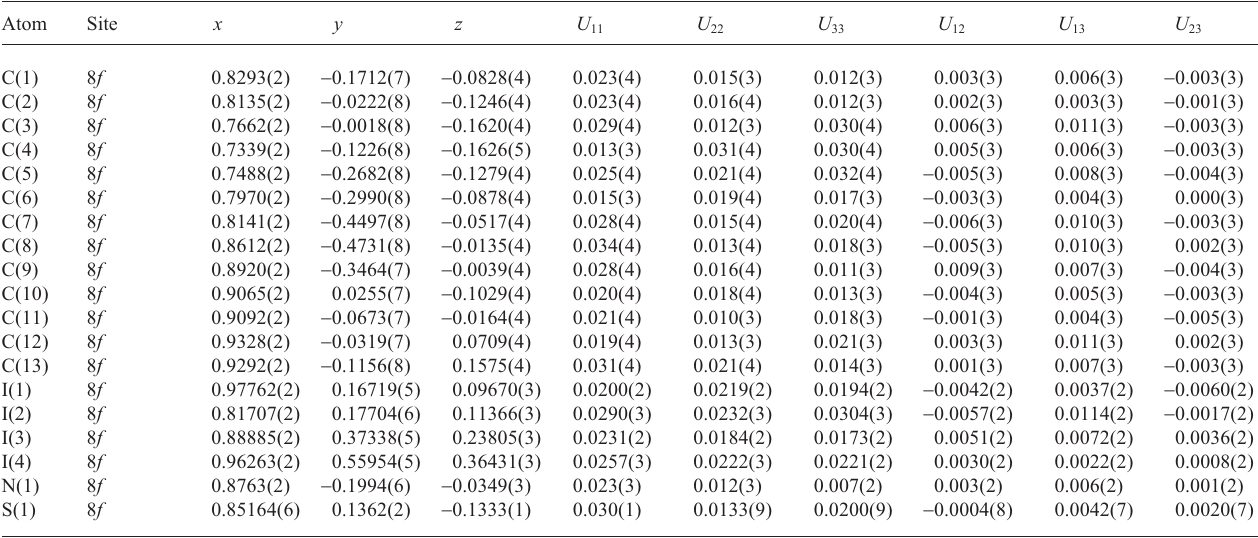
Table 3. Atomic coordinates and displacement parameters (in Å 2 )